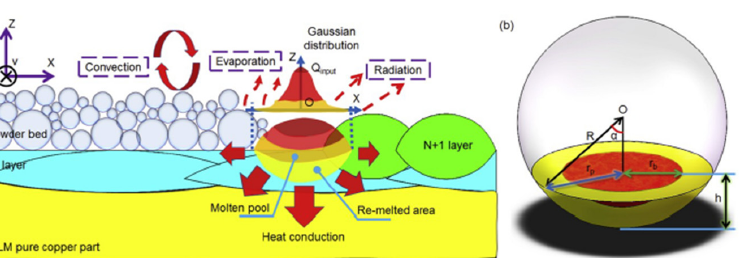
Figure 12. Schematics of heat transfer process of a molten pool during SLM processing ( a ) Heat transfer in laser molten pool during the SLM process; ( b ) simplified mathematical model of the laser molten pool. Reproduced with permission from [9] Elsevier, 2020.